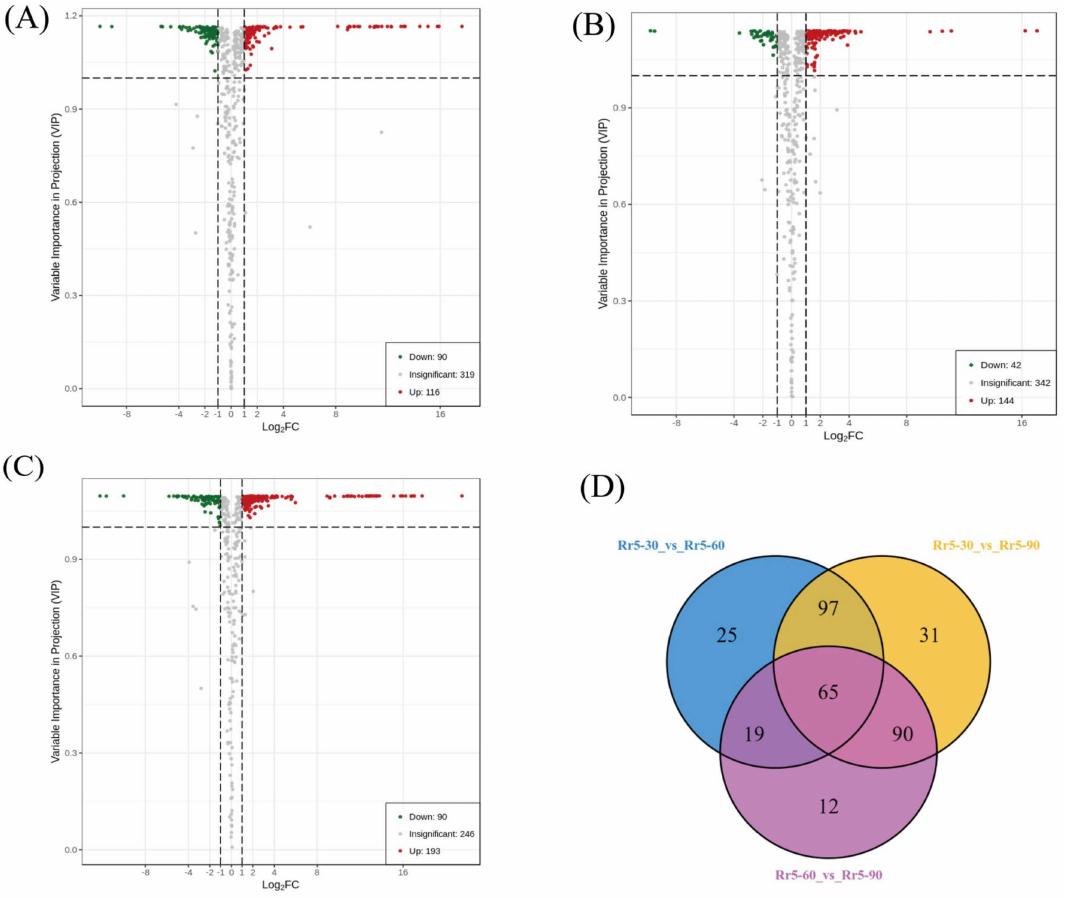
Figure 3. Differential accumulation of metabolites. Differential metabolites were defined as metabo- lites with fold-change ≥ 2 or ≤ 0.5 in the comparison of two samples and fulfilling the condition of VIP ≥ 1. ( A ) Rr5-30 vs. Rr5-60 volcano plot. ( B ) Rr5-60 vs. Rr5-90 volcano plot. ( C ) Rr5-30 vs. Rr5-90 volcano plot. ( D ) Venn diagram. Each circle represents a comparison group, with the numbers in the overlapping part of the circle; the circle represents the number of SCMs shared between the comparison groups. The number without overlap represents the number of unique SCMs in the comparison